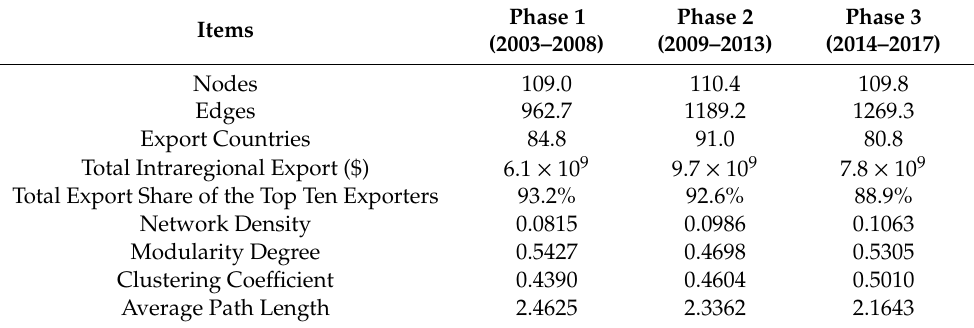
Table 4. Features of intraregional rolling stock trade networks (means of annual values in each phase).